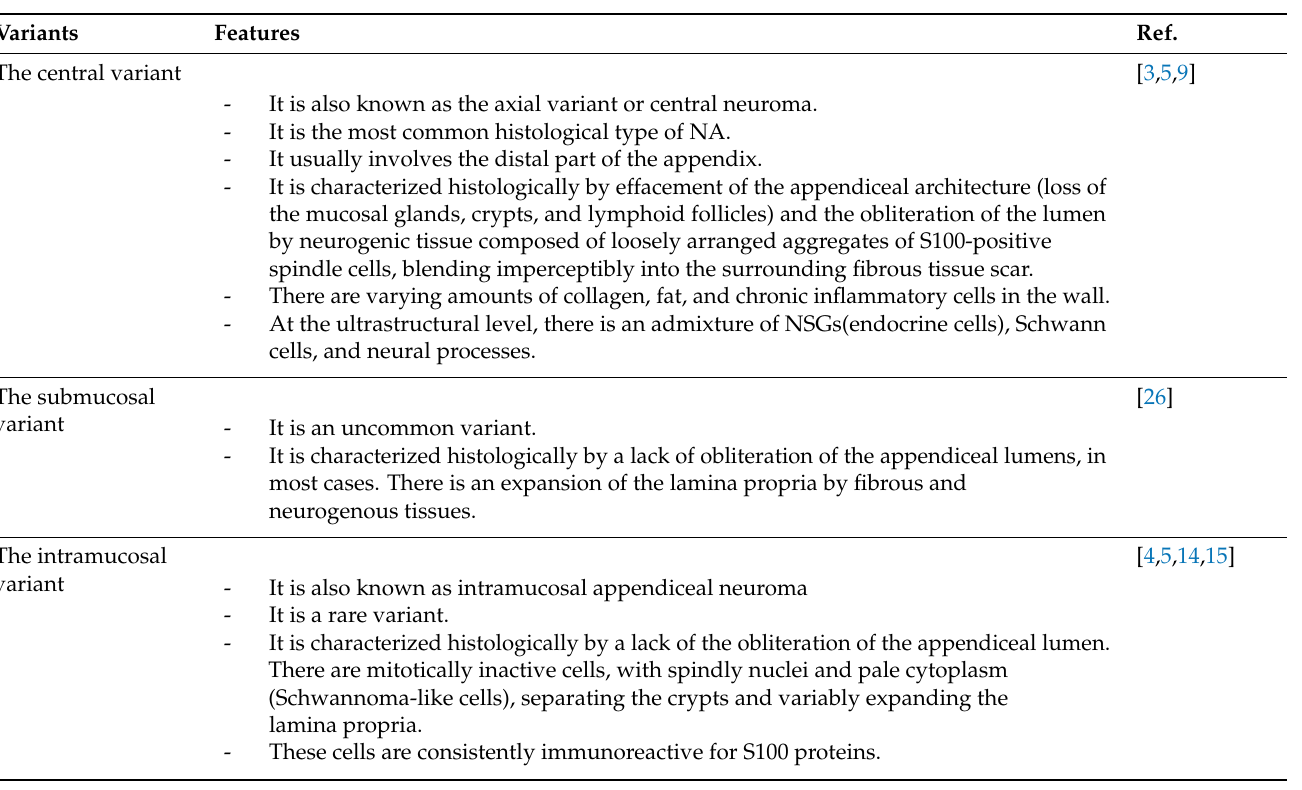
Table 3. The histological, immunophenotypic, and ultrastructural features of the variants of neuro- genic